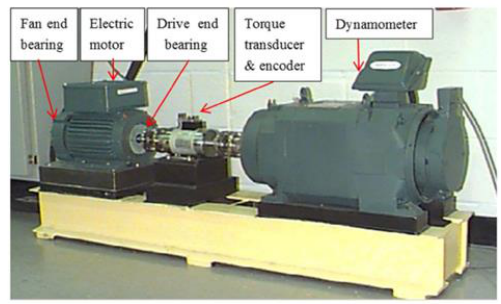
Figure 15. Test rig of Bearings Data Center at Case Western Reserve University [65].